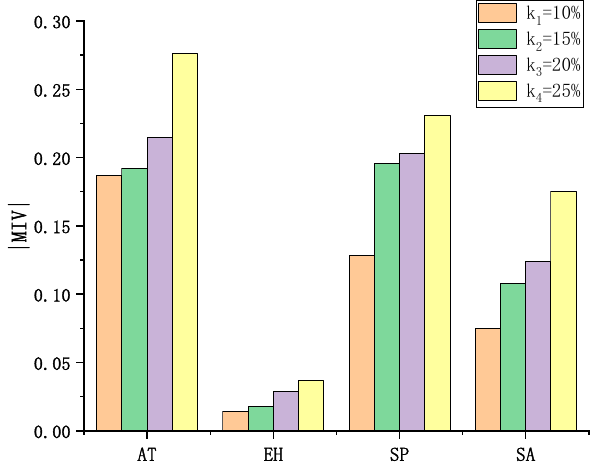
Figure 14. Change chart of | MIV | for four impact factors.